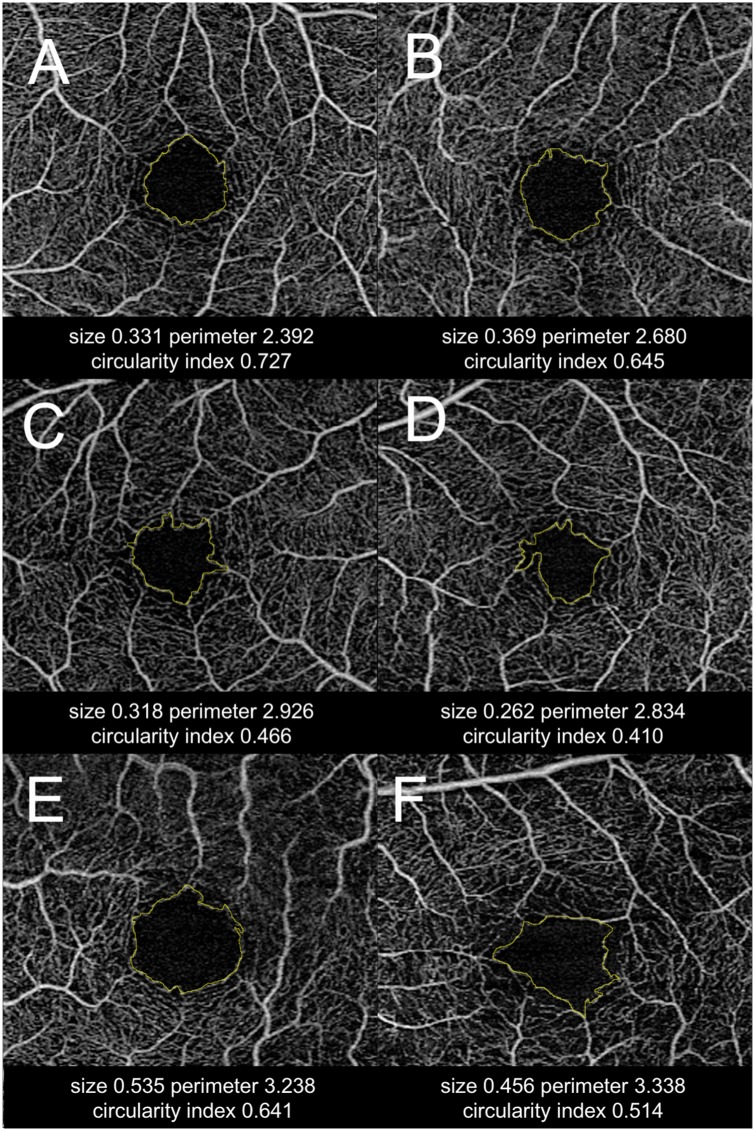
Representative cases with different foveal avascular zone (FAZ) assessment.Two healthy cases (A, B) and four glaucoma cases (C, D, E, F). (A, B) Healthy eyes have a relatively smaller FAZ size and a higher circularity index. (C, D) Glaucoma patients with remarkable foveal capillary dropout, which is reflected in lower circularity index. (E, F) Advanced glaucoma patients with notably enlarged FAZ size (E) or distorted FAZ shape (F).